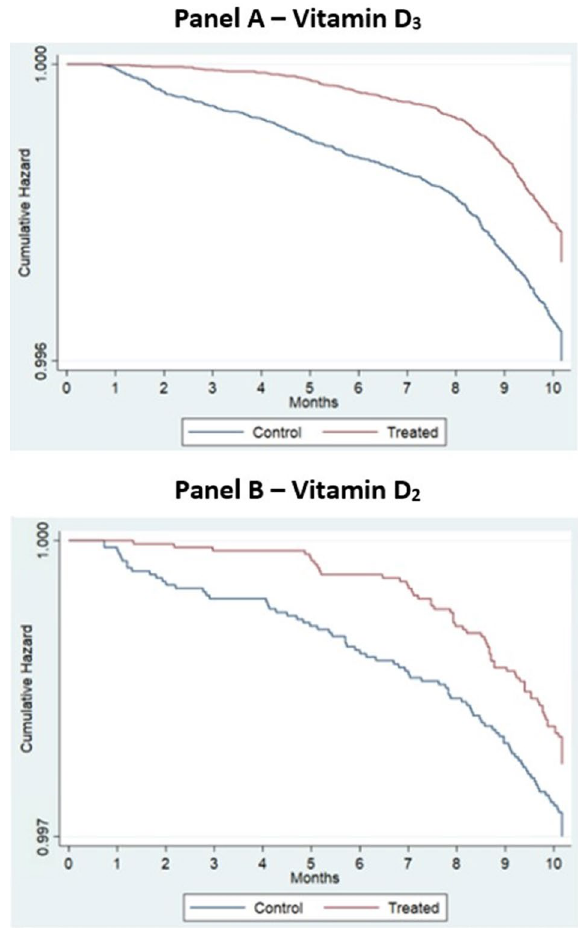
Figure 2. Kaplan Meier curves for vitamin D 3 and D 2 supplement patients versus control—time-to COVID-19 infection ending in mortality within